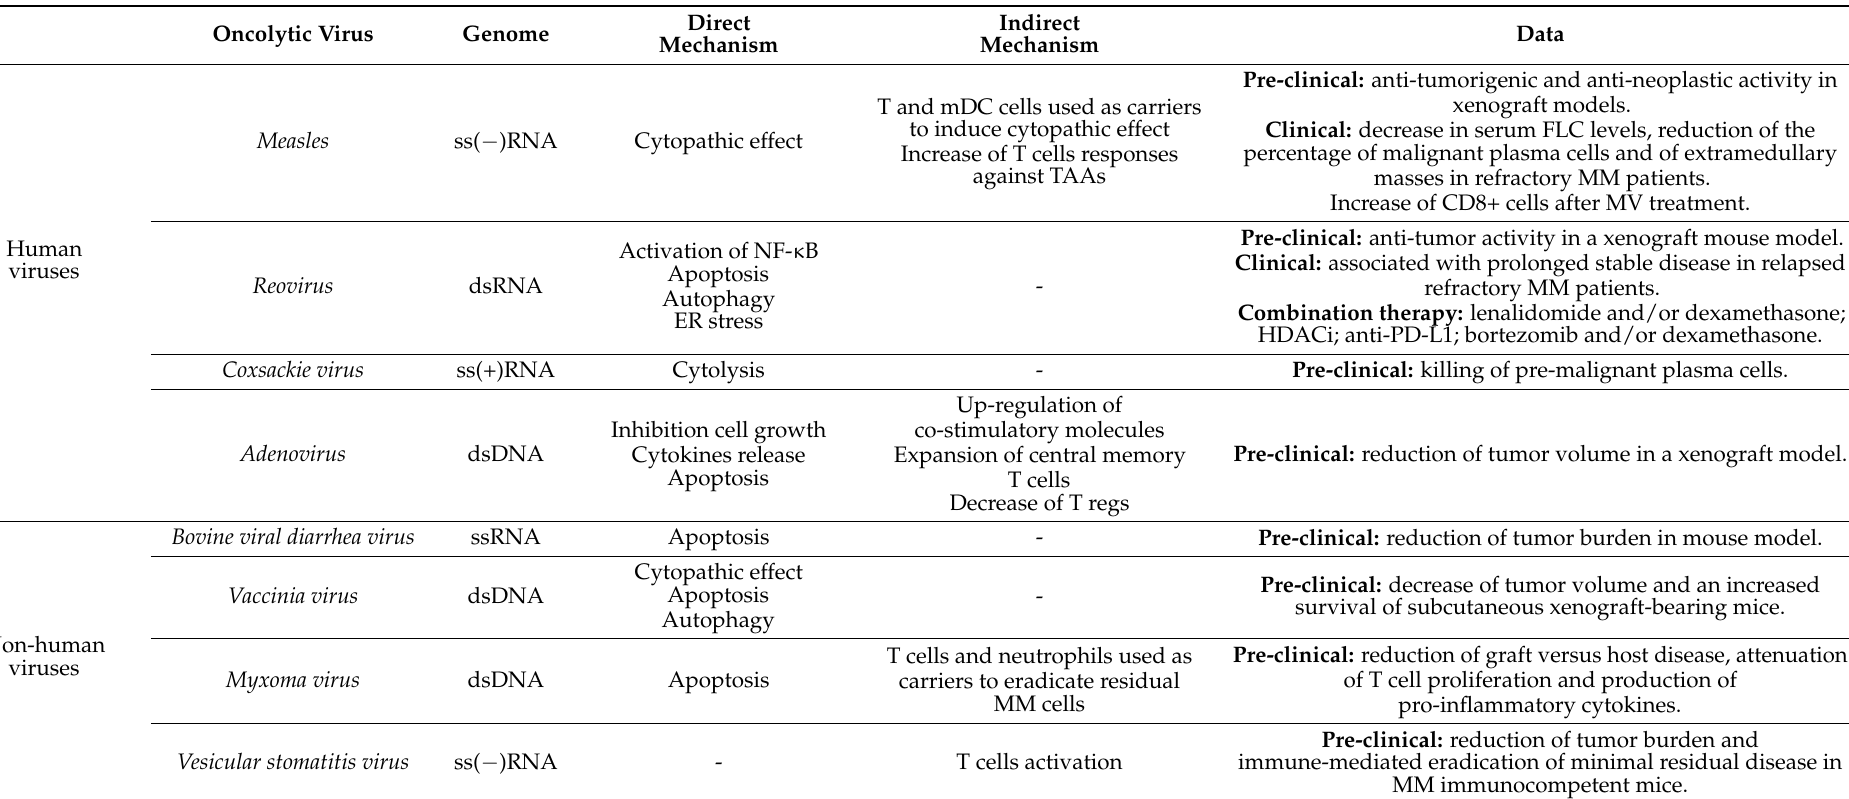
Table 1. Human and non-human oncolytic viruses currently studied for multiple myeloma therapy.